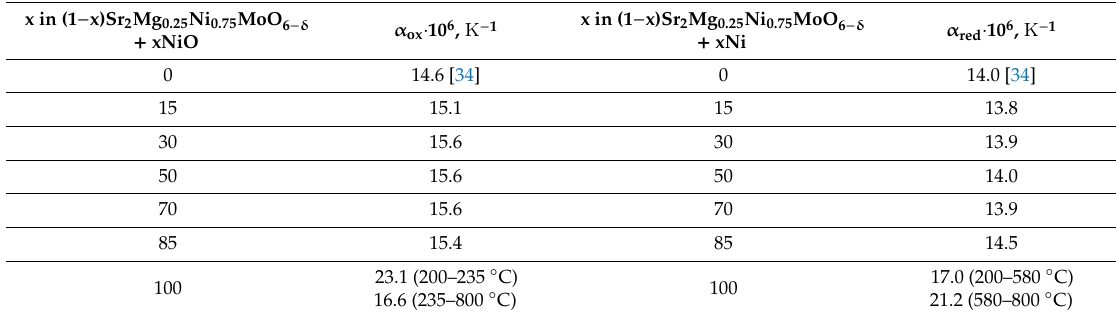
Table 1. The average TECs of the composite materials in air ( α ox ) and 50%H 2 / Ar ( α red ) atmospheres. These values were calculated from dilatometry curves obtained in cooling